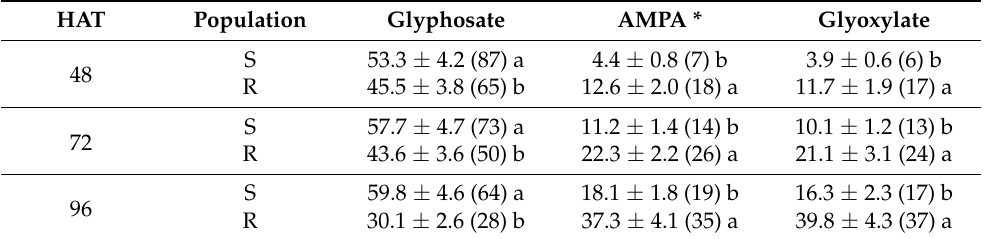
Table 2. Amount of glyphosate and metabolites (nmol g − 1 fresh weight) in resistant (R) and sus- ceptible (S) saltmarsh aster populations at different hours after treatment (HAT) with 720 g ae ha − 1 of